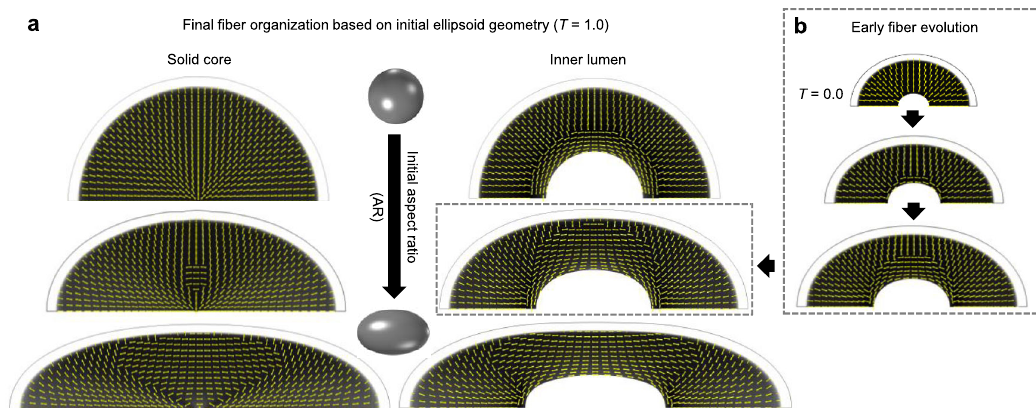
Fig. 6 Geometric factors induce reorganization of deeper subcortical layers. a Deep fi ber organization resulting for ellipsoidal cases of increasing elongation, as re fl ected by initial geometry aspect ratio (AR). From top to bottom, initial AR = 1.01, 1.10, 1.25. Results are shown for solid ellipsoids (left) and ellipsoids containing an inner lumen (right) at simulation time T = 1. For prolate ellipsoidal geometries, cortical expansion induces tension parallel to the long axis and reorganization of fi bers in this direction. For models containing an internal lumen as opposed to solid core, tangential tension also develops at the interface, with reorganization of fi bers to run along the ventricular surface. b Evolution of deep fi ber organization in an ellipsoidal model with internal lumen, approximating the shape of the brain and lateral ventricle. From top to bottom, simulation time T = 0, 0.5, 0.75.